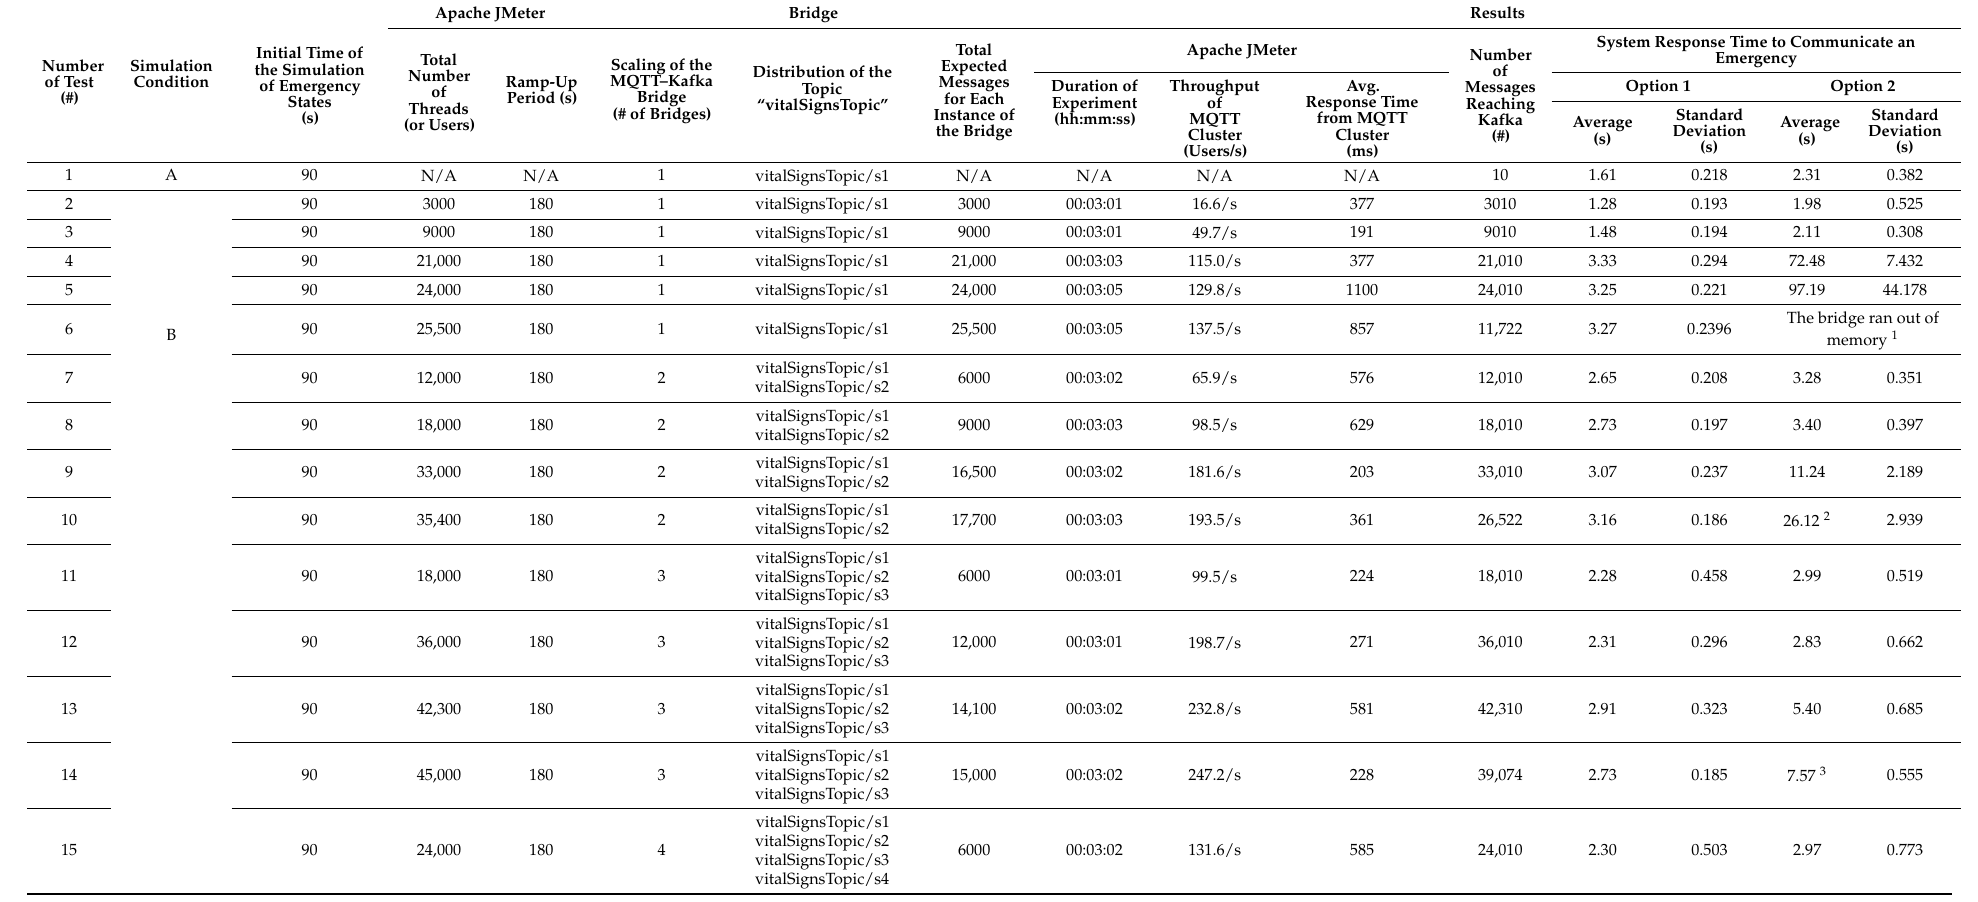
Table 6. Information on the test environment and results of the measurement on the average response time to notify an